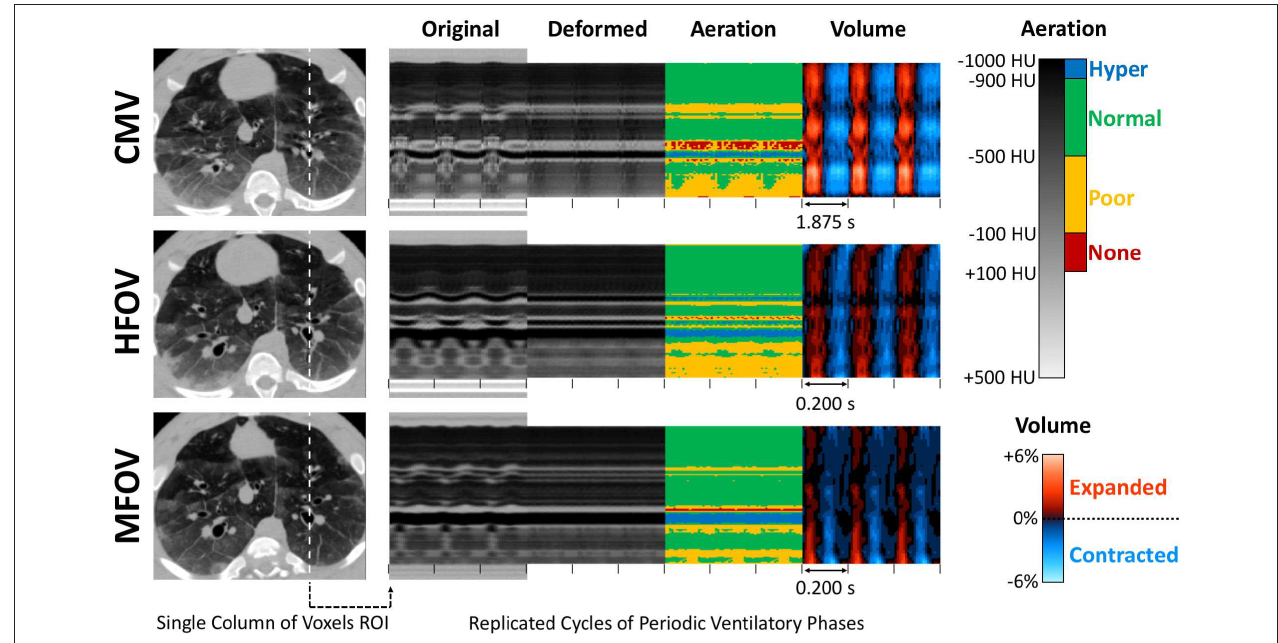
FIGURE 3 | Four-dimensional image registration was used to deform images such that respiratory structures were aligned to a single reference phase. After registration, regional aeration and volume change throughout the lung were assessed by the variations in deformed image voxel value and determinant of the Jacobian matrix of the deformation. This technique was applied during conventional mechanical ventilation (CMV), high-frequency oscillatory ventilation (HFOV), and multi-frequency oscillatory ventilation (MFOV). Ventilatory cycle duration is indicated by spacing between tick marks. In this example, each ventilatory cycle corresponds to a sequence of images representing 21 distinct ventilatory phases. Note that multiple cycles of each ventilation waveform are shown for clarity, however all cycles are identical replicates. See also Supplementary Animations S-1, S-2